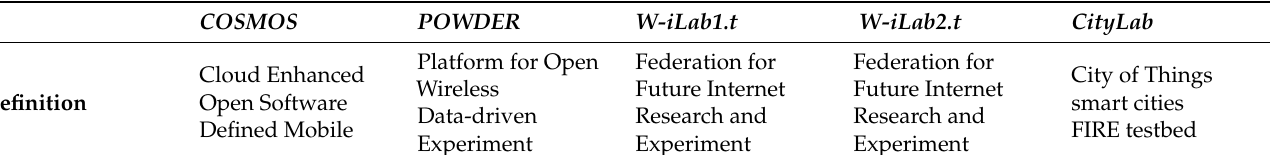
Table 1. Architecture comparison among POWDER, COSMOS, and